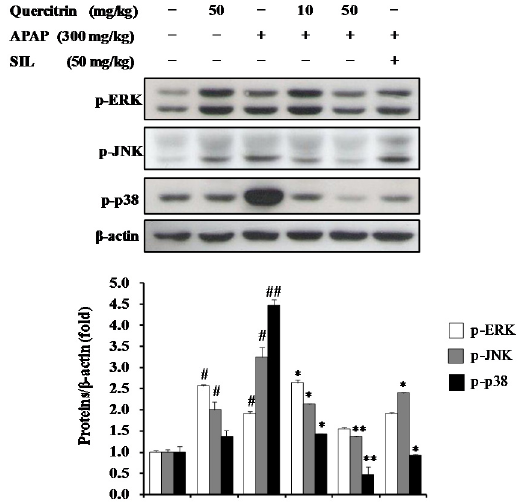
Figure 8. Effects of quercitrin on MAP kinases in APAP intoxicated mice. The phosphorylations of ERK, JNK and p38 MAPK were analyzed by Western blotting. Protein expression levels were normalized with β -actin. All data represent means ± SD of five mice in each group. Significant differences were ( ## ) p < 0.01 or ( # ) p < 0.05 as compared with the control; (**) p < 0.01 or (*) p < 0.05 as compared with APAP group.